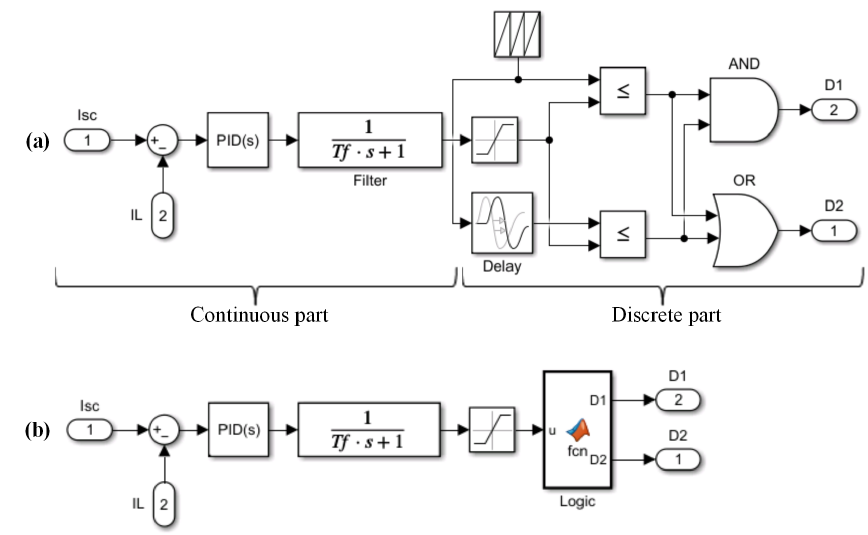
Figure 7. Control system of the solar simulator: ( a ) discrete option; ( b ) continuous